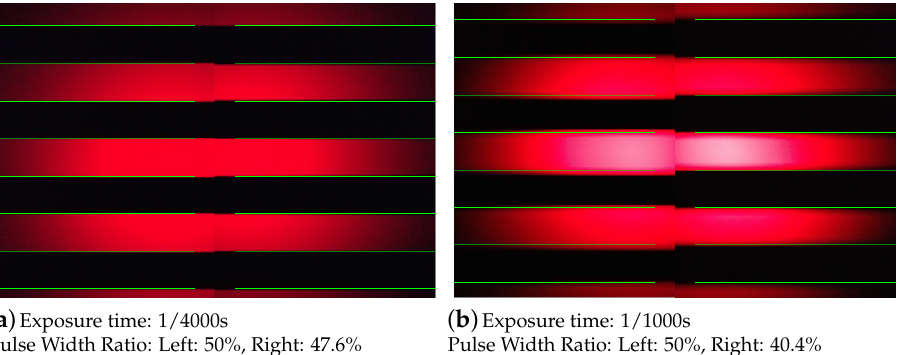
Figure 16. Comparison of resulting stripe pattern using different pulse width